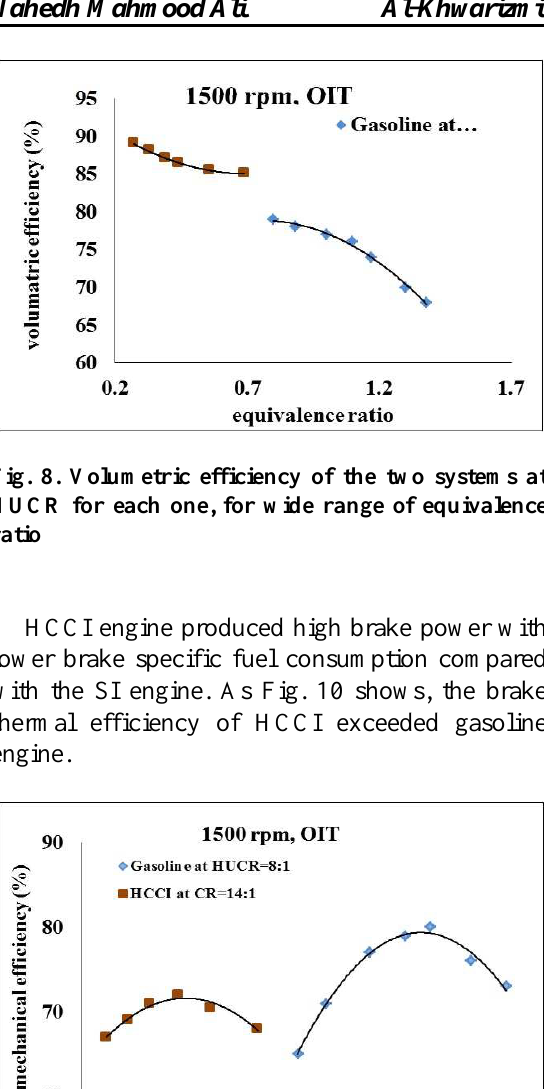
Because of air overabundance in lean mixtures concentrations were operation, the resulted CO 2 limited to the minimum values, as Fig. 12 appears. The CO levels are at the minimal values 2 compared to those produced from the SI engine. Fig. 13 represents the emitted CO concentrations for the two tested engines. Partial oxidation of fuel to CO can occur at extremely lean mixtures. Three temperatures govern the HCCI engine. The required auto-ignition temperature to get fuel/air mixture ignited; the combustion temperature must reach at least 1400 K to have good combustion efficiency, in the same time, this temperature must not increase to more than 1900 K to prevent the formation